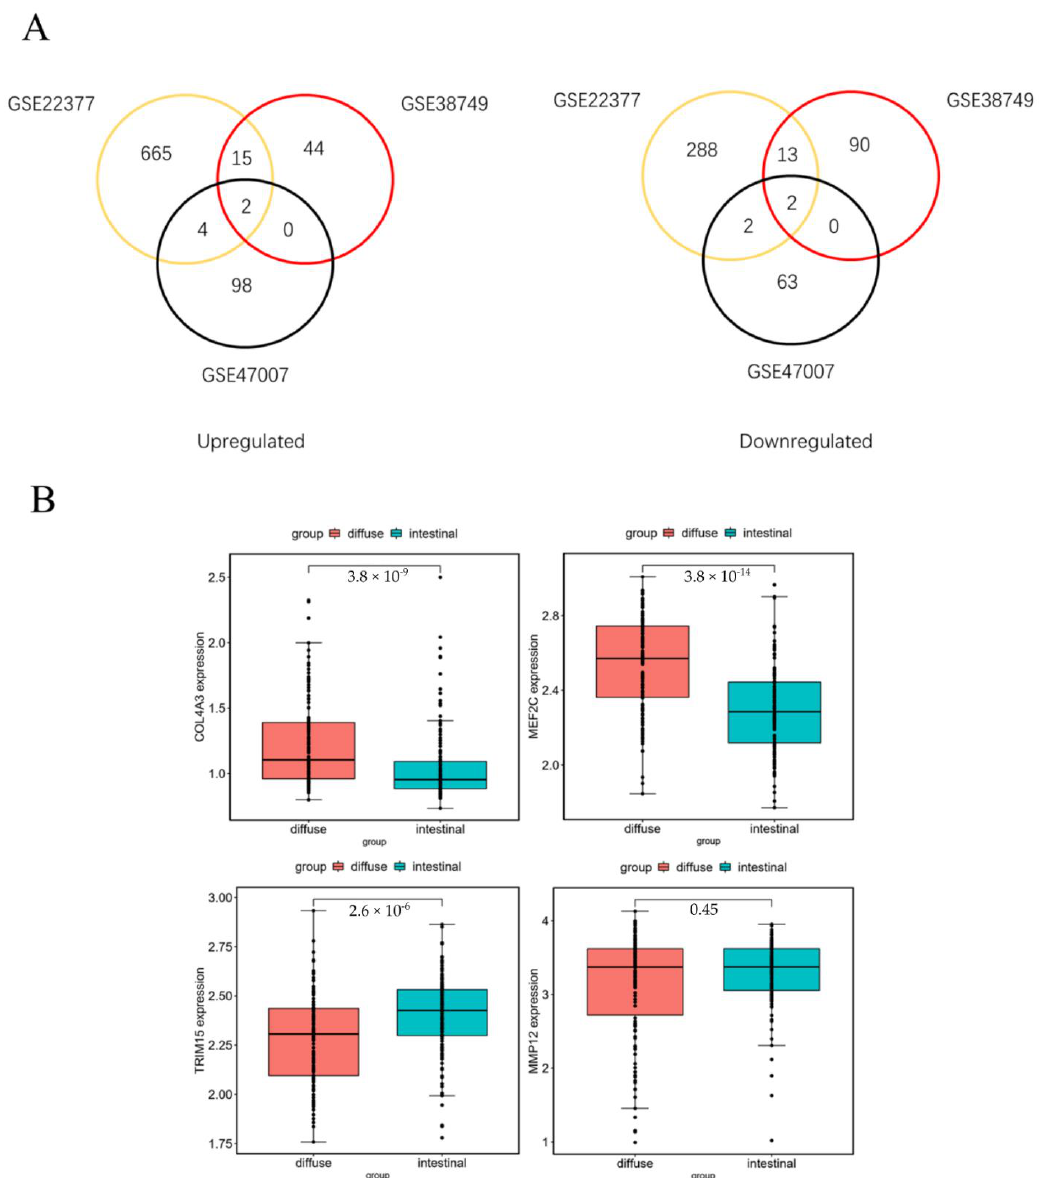
Figure 2. ( A ) The Venn diagram shows the DEGs with upregulated genes and downregulated genes in diffuse-type GC. ( B ) Expression levels of four DEGs between diffuse-type and intestinal-type gastric cancer were validated in GSE62254 dataset.